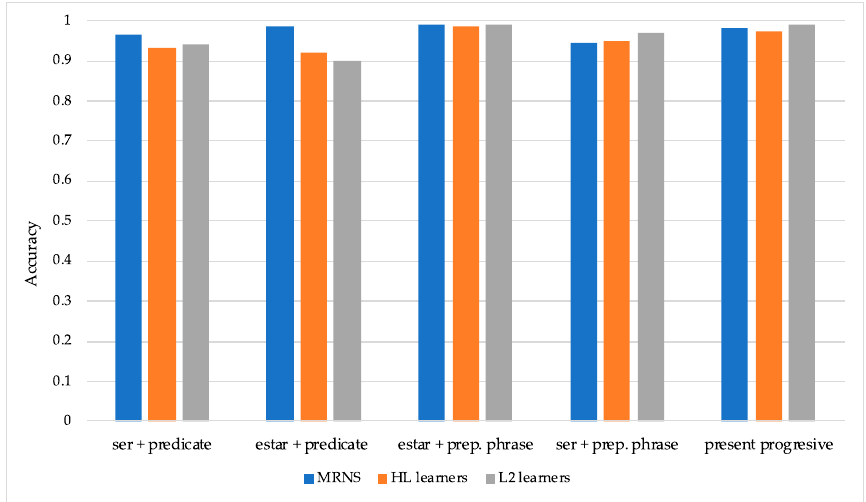
Figure 2. GJT: Mean accuracy ratings on grammatical sentences.